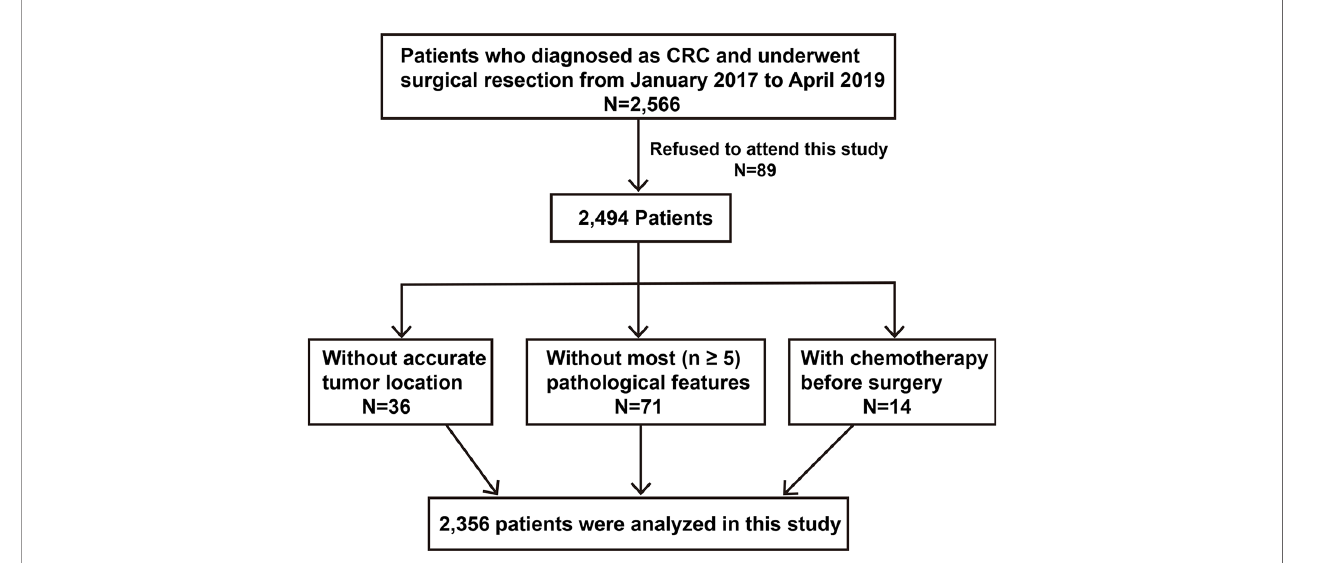
FIGURE 1 | Diagram for the selection of CRC patients for this study. CRC, colorectal